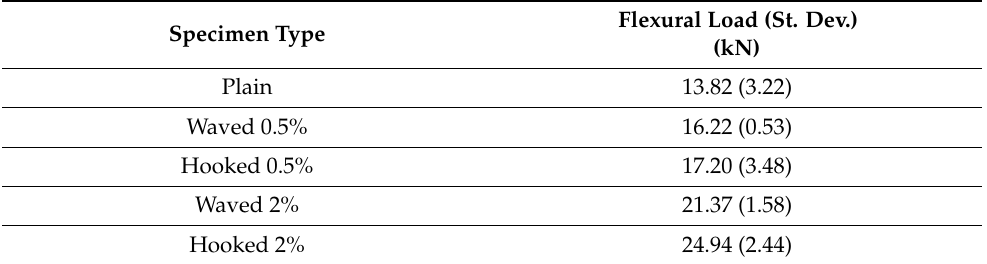
Table 2. Load capacity for concrete specimens with a different type and content of fibers.